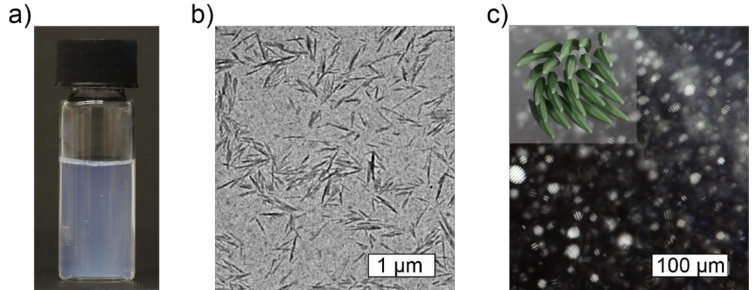
Figure 3. Cellulose nanocrystals. ( a ) A photograph of 1 wt% aqueous solution of cotton-based CNCs produced using sulfuric acid hydrolysis, i.e., below the critical liquid crystalline concentration. It appears grayish due to scattering and behaves like water. ( b ) TEM image of cotton-based CNCs. ( c ) Polarized optical microscopy image showing cholesteric tactoids in an 8.0% cotton-based CNC solution, i.e., above the critical liquid crystalline concentration. The inset shows a schematic illustration of a left-handed cholesteric CNC